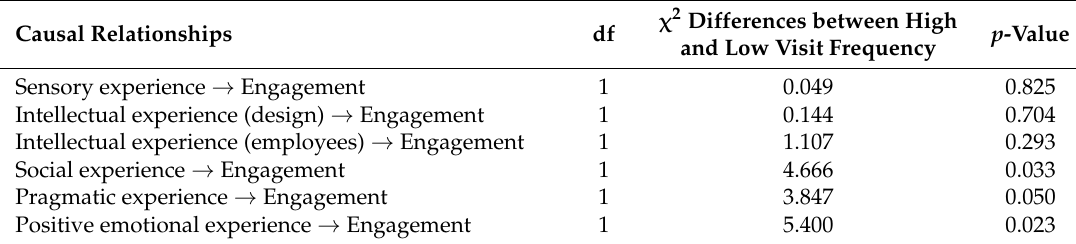
Table 9. Hypothesis test result in a multi-group